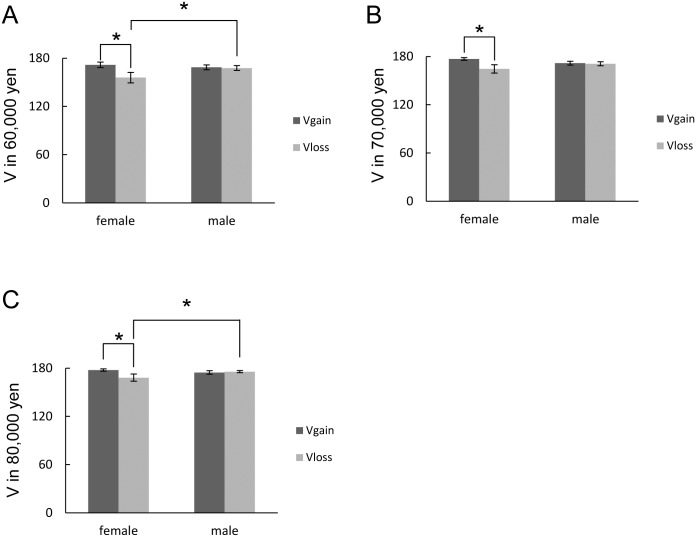
Subjective valuation of gain happiness and loss aversion.V of (A) 60,000 yen, (B) 70,000 yen and (C) 80,000 yen. * P < 0.05, post-hoc Holm multiple comparisons following ANOVA. Data are expressed as mean ± SEM. Vertical axis: a 180 mm scale of the paper–pencil task.